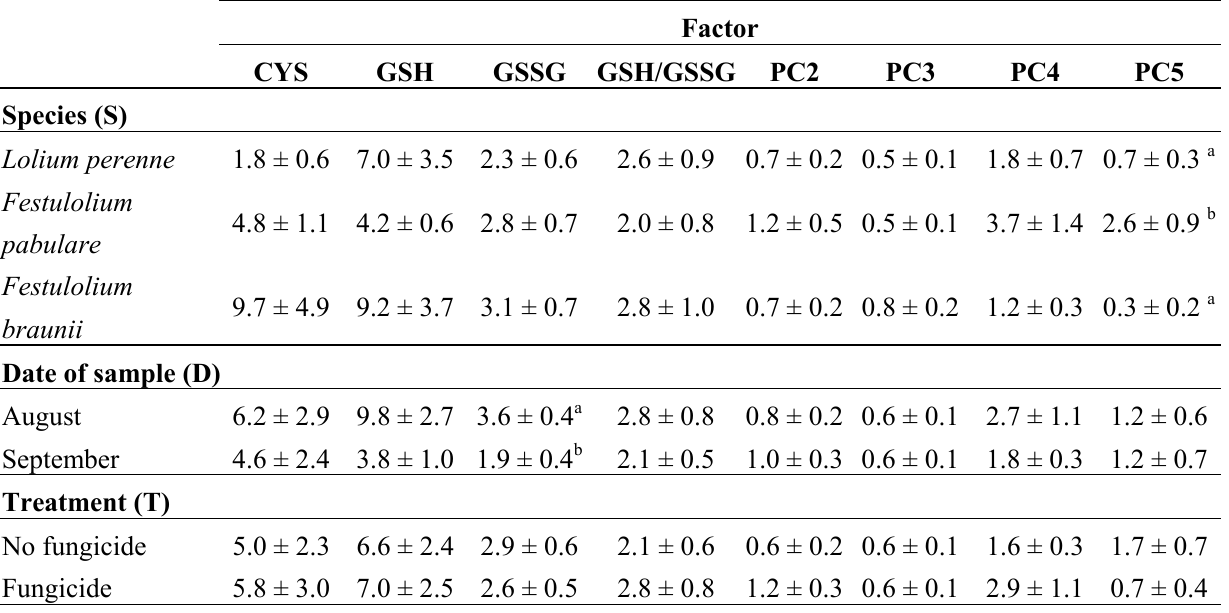
Table 4. Effect of Species (S), Date of sample (D), and Treatment (T) on contents of CYS, GSH, GSSG, PC2, PC3, PC4, PC5 and GSH/GSSG ratio in field experiment. Content of CYS, GSH and GSSG is expressed as µg/g of fresh weight. PC2, PC3, PC4 and PC5 are expressed as ng/g of fresh